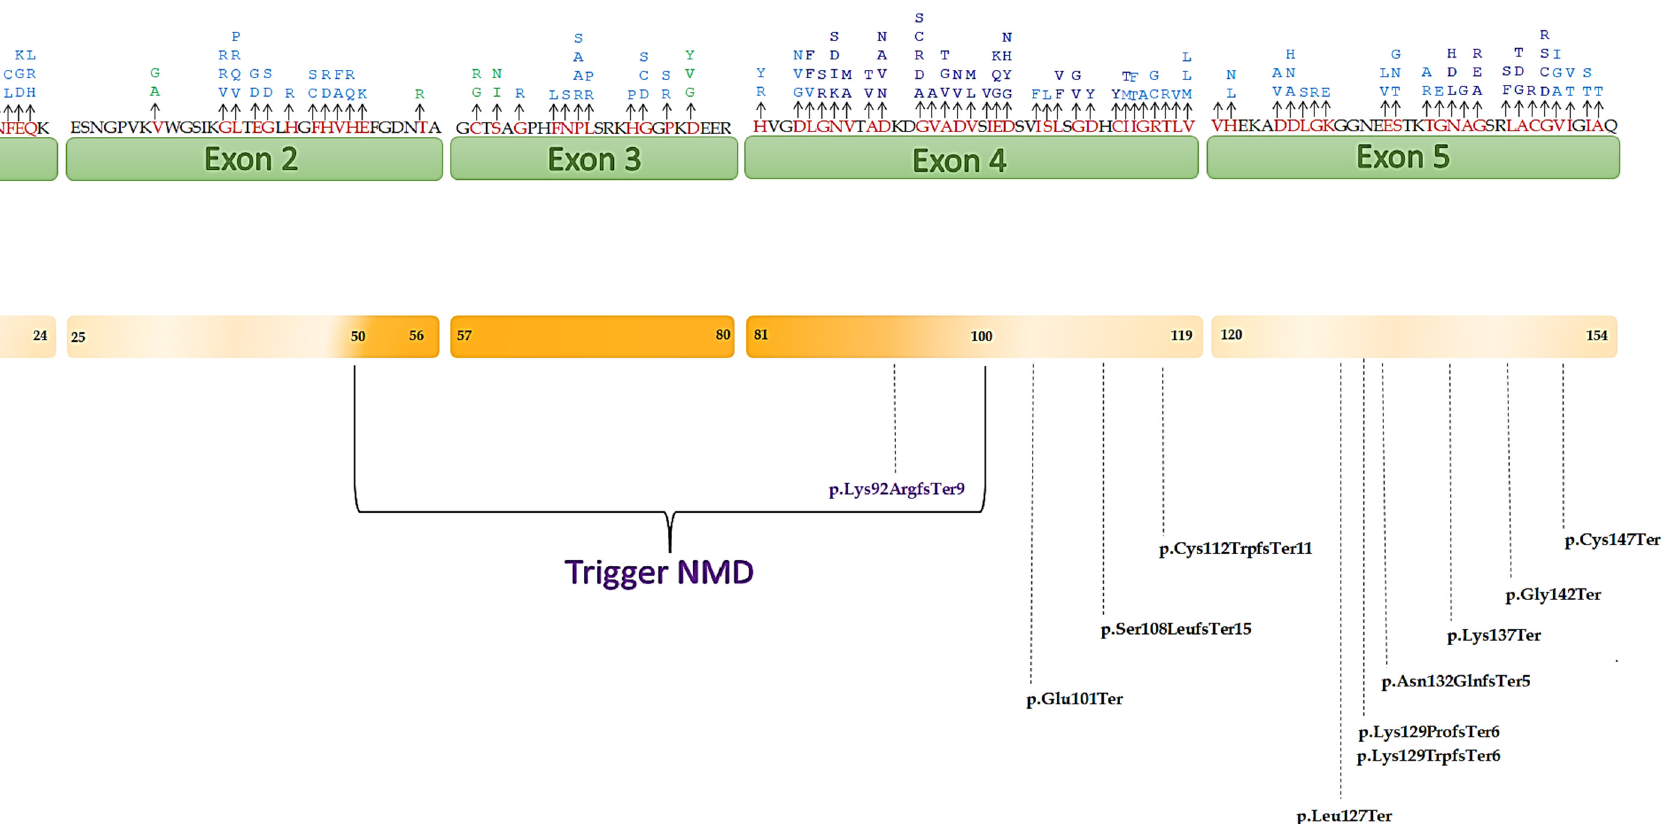
Figure 1. ( A ) Schematic representation of SOD1 showing the localization of variants that were assigned PM1. The amino acid changes are represented in red. The different weights of the criterion are represented by the different colors: dark blue, PM1_Strong; light blue, PM1_Moderate; green, PM1_Supporting. The numbers under the exons represent the amino acid distribution; ( B ) localization of variants that undergo/do not undergo NMD. The variants localized in SOD1 region where PTCs trigger NMD are represented in purple, the variants localized in the region that do not undergo NMD are colored in black.